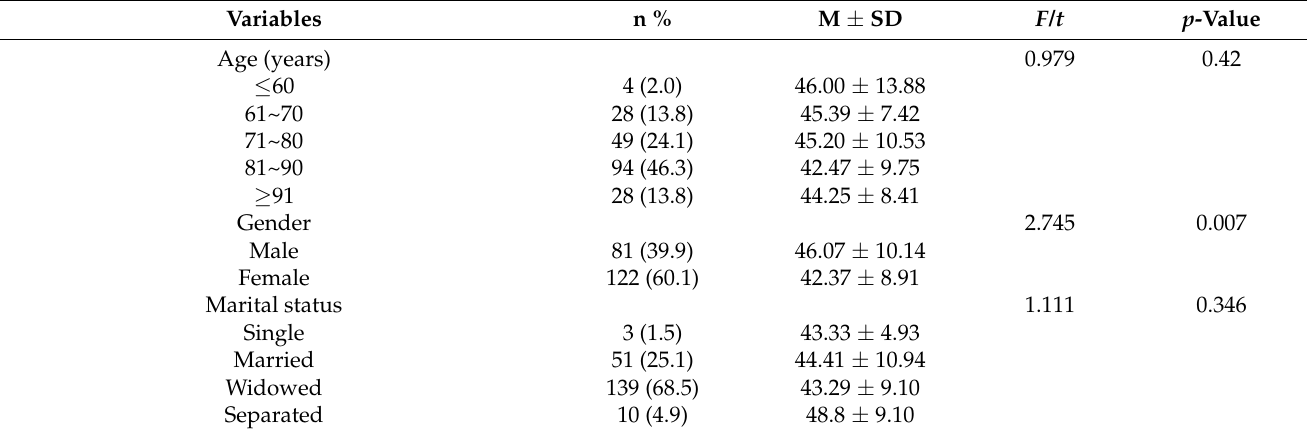
Table 1. General information of study participants and univariate analysis of alexithymia (n = 203).